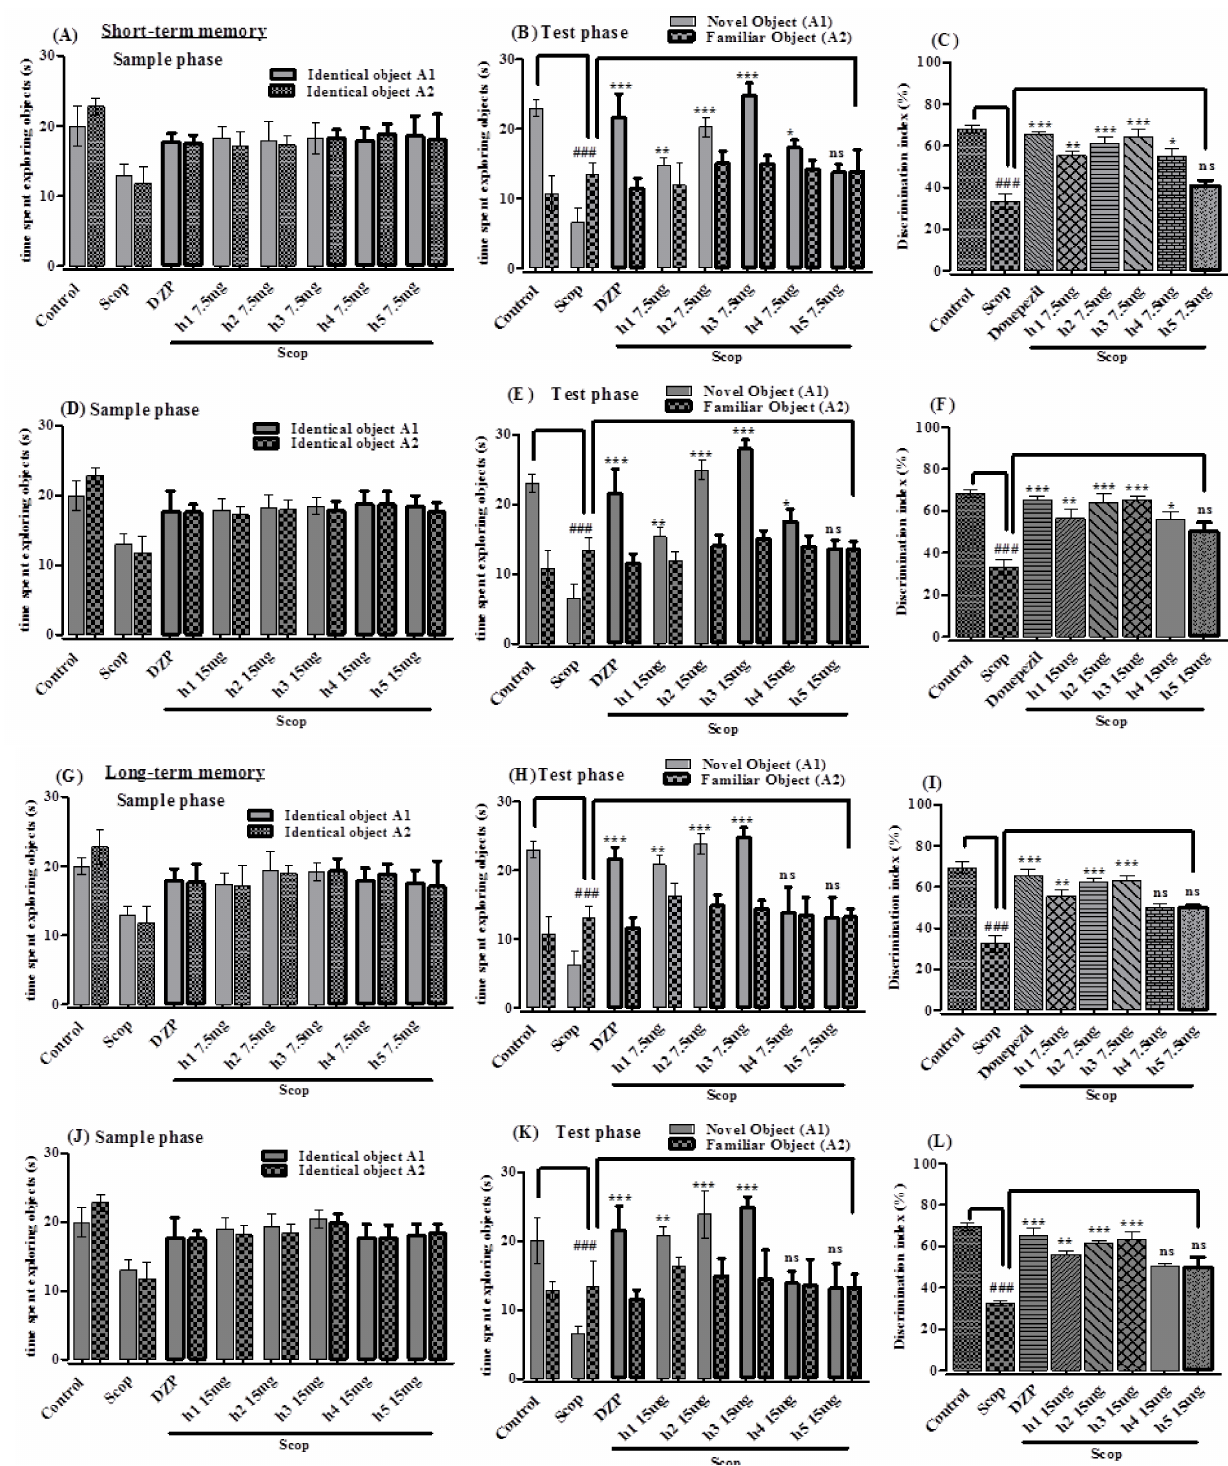
Figure 4. The effect of the synthesized curcumin analogs (h1–h5) in NORT ( A , D , G , J ) sample phase, ( B , E , H , K ) test phase ( C , F , I , L ) % DI versus scopolamine-treated group for the evaluation of short- and long-term memory. All values are presented in mean ± SEM ( n = 6), ### p < 0.001 vs. normal control. Significantly different values are with respect to the amnesic (scopolamine) group; p -value < 0.001, < 0.01, < 0.05, > 0.05 are expressed as ***, **, * and ‘ns’, respectively. One-way ANOVA followed by Dunnett’s multiple comparison tests was applied on this